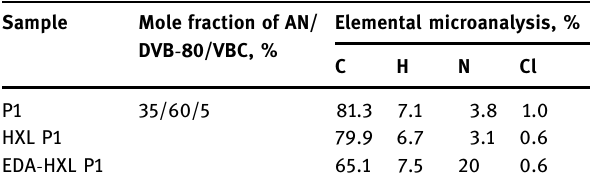
Table 1: Elemental microanalysis data of poly ( AN - co - DVB - 80 - co - VBC ) and hypercrosslinked poly ( AN - co - DVB - 80 - co - VBC ) terpoly - mers before and after chemical modi fi cation Sample